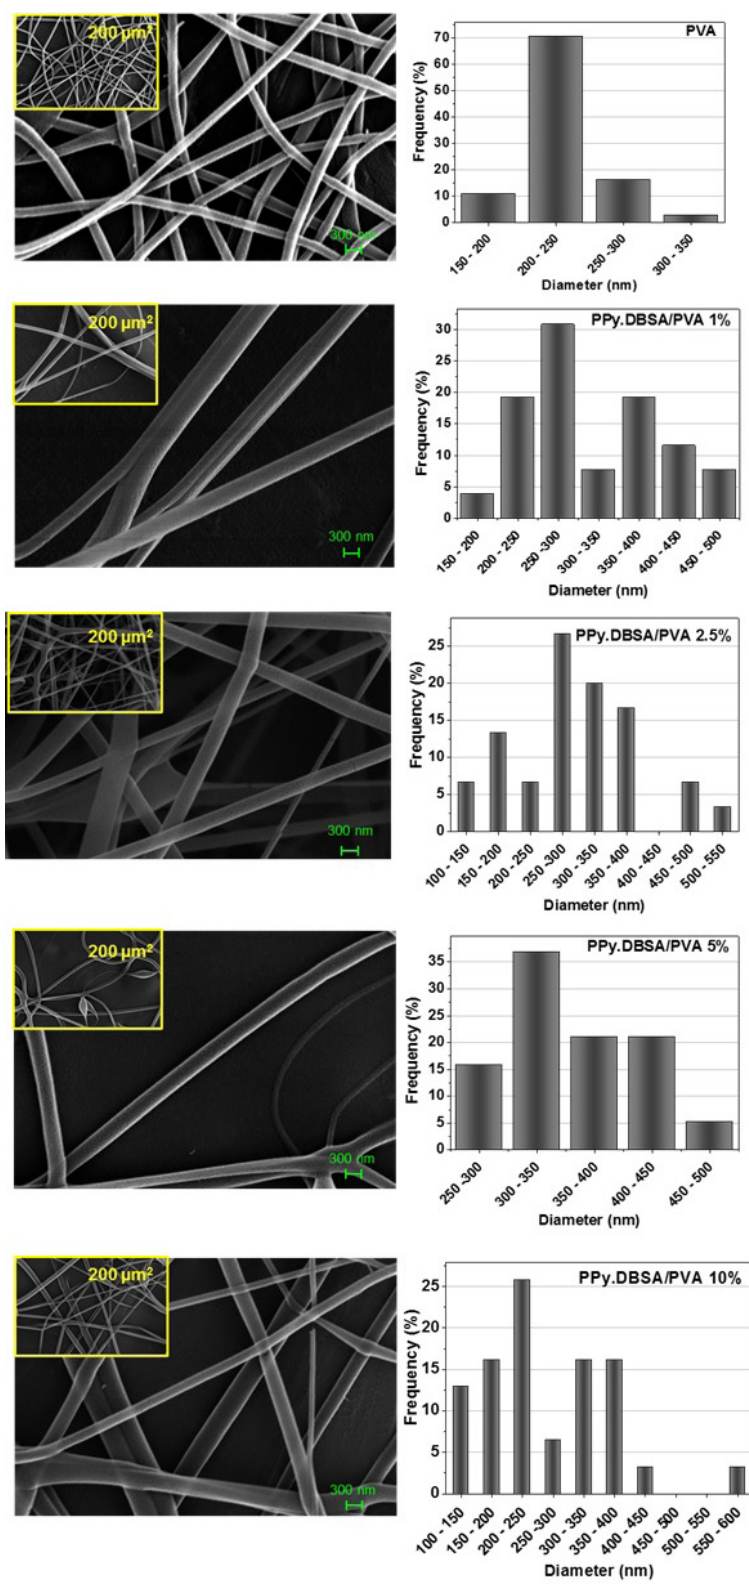
Figure 3. SEM and frequency of diameters of PPy.DBSA/PVA nanofibers in different mass proportions of 0%, 1%, 2.5%, 5% and 10%, with a magnification of 35,000x and 15,000x covering a surface of 200 µm 2